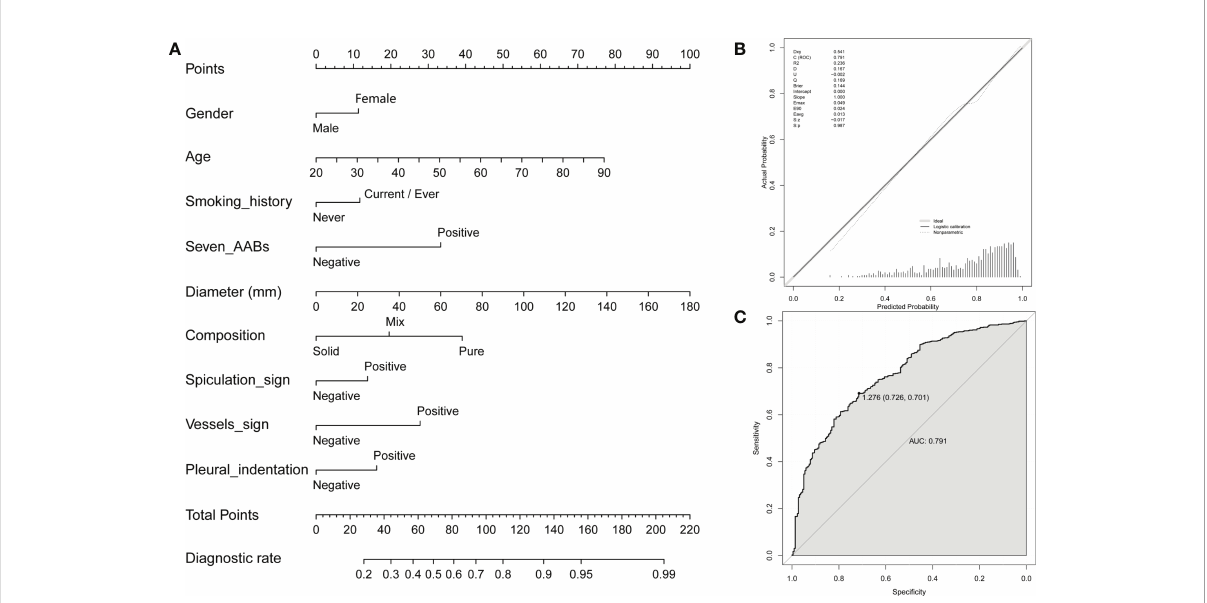
FIGURE 4 A nomogram for predicting probability of malignant disease. (A) A nomogram for predicting probability of malignant disease combining the 7- AAB panel with patient clinical features; (B) The calibration curve of the nomogram; (C) Receiver operating characteristic (ROC) curve and the corresponding area under the curve (AUC) using the nomogram to predict NSCLC in the training